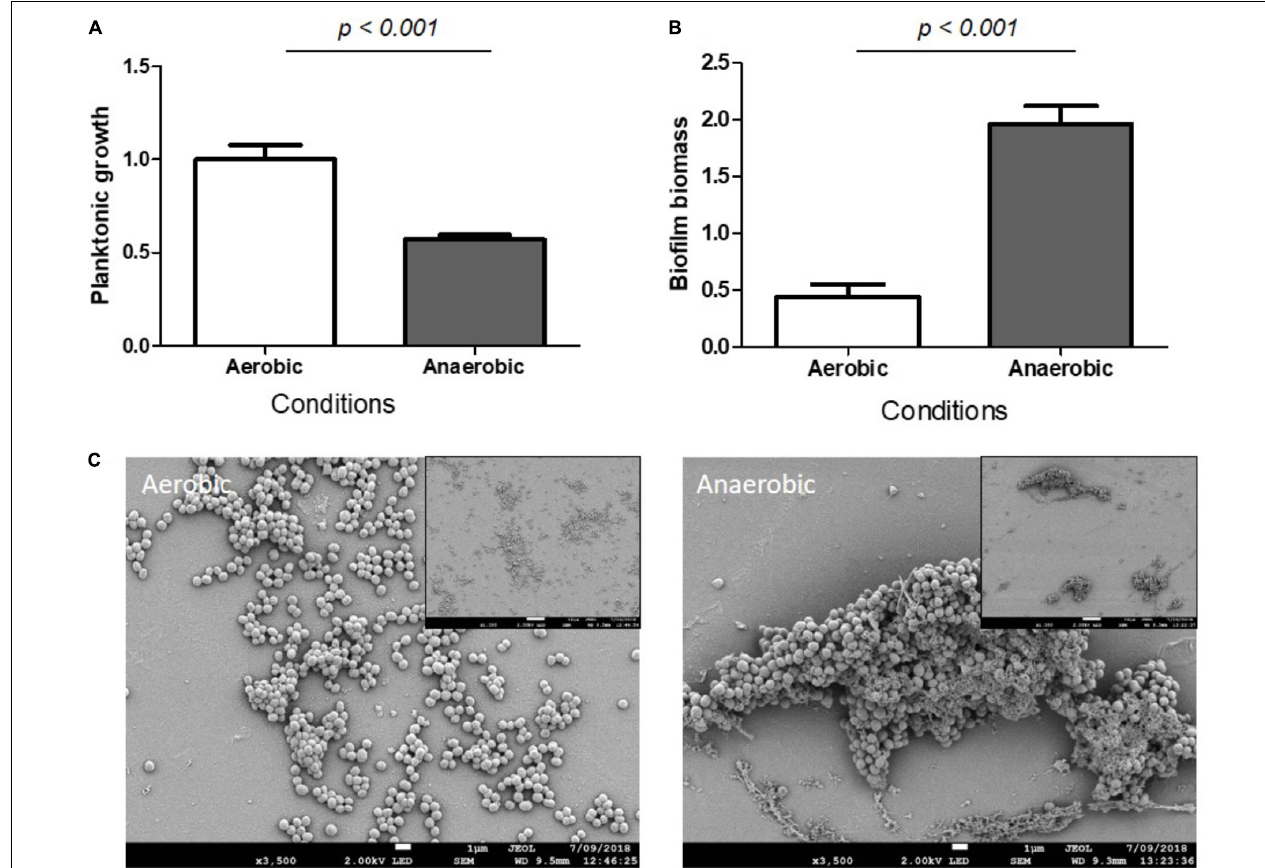
FIGURE 3 | Hypoxia increased S. aureus biomass biofilm. Planktonic growth normalized on control (A) and biofilm biomass quantified by crystal violet staining (B) under aerobic and anaerobic conditions. ( n = 9). Scanning Electronic Microscopy (SEM) (C) . Main panels: scale bar = 1 µ m and insert panels showing the homogeneity on a wide field: scale bar = 10 µ